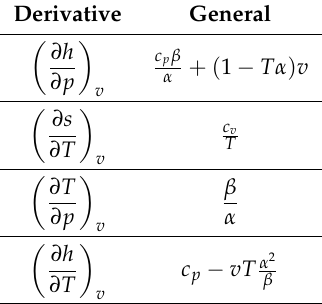
Table A2. Constant Volume.